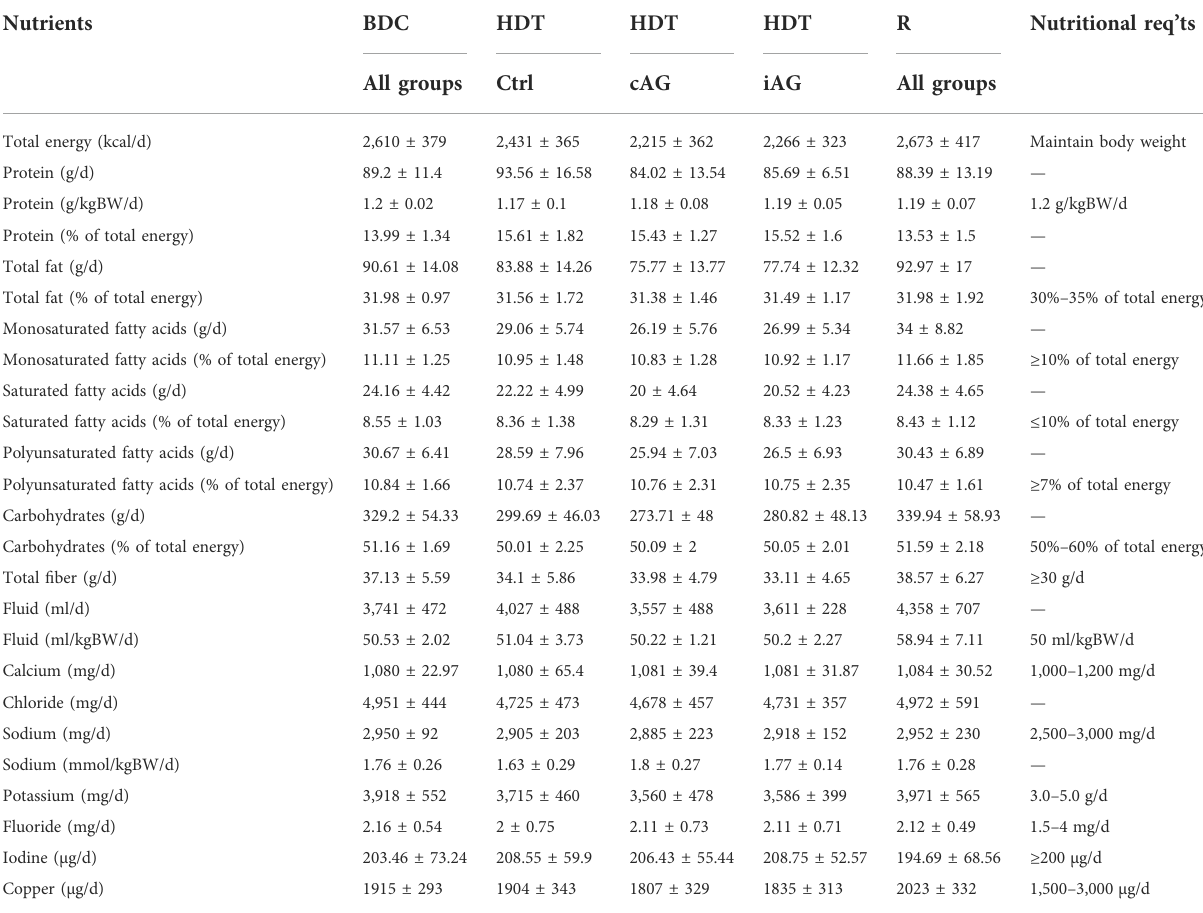
TABLE 4 Standardized nutritionalintake for each experimentalgroup (Mean ±SD). The AGBRESA nutritional requirements are presented in the right- most column for